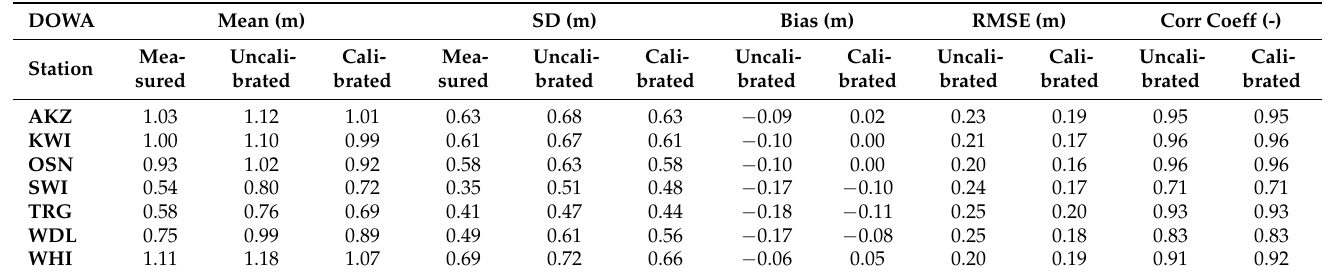
Table 6. Significant wave height statistical parameters calculated for the calibrated and uncalibrated SWAN models, 5.0 km × 5.0 km computational grid, forced by the DOWA database.